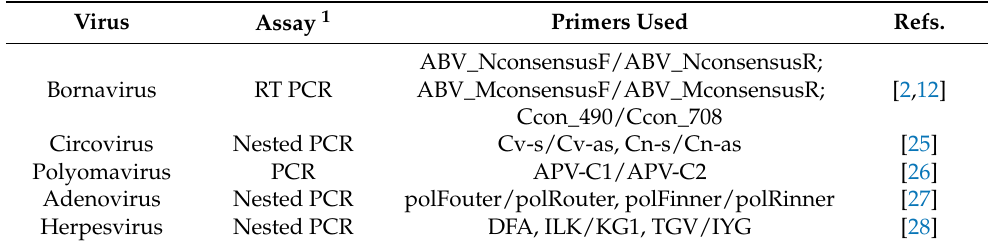
Table 1. PCR-based methods to detect viruses in clinical samples from canaries.